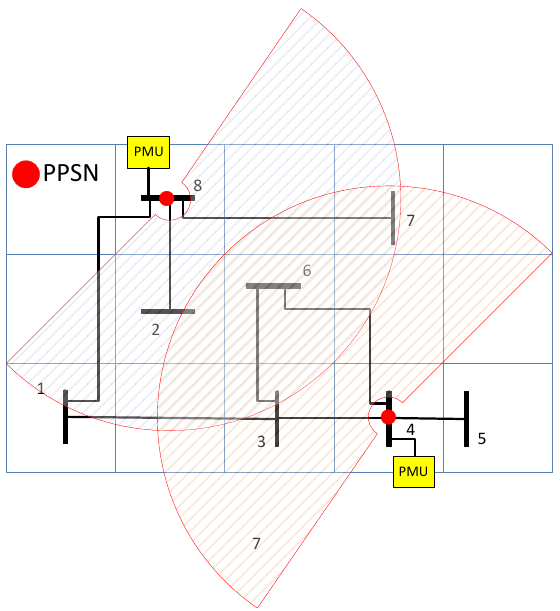
Figure 4. Eight-bus test system for a communication system observability analysis.